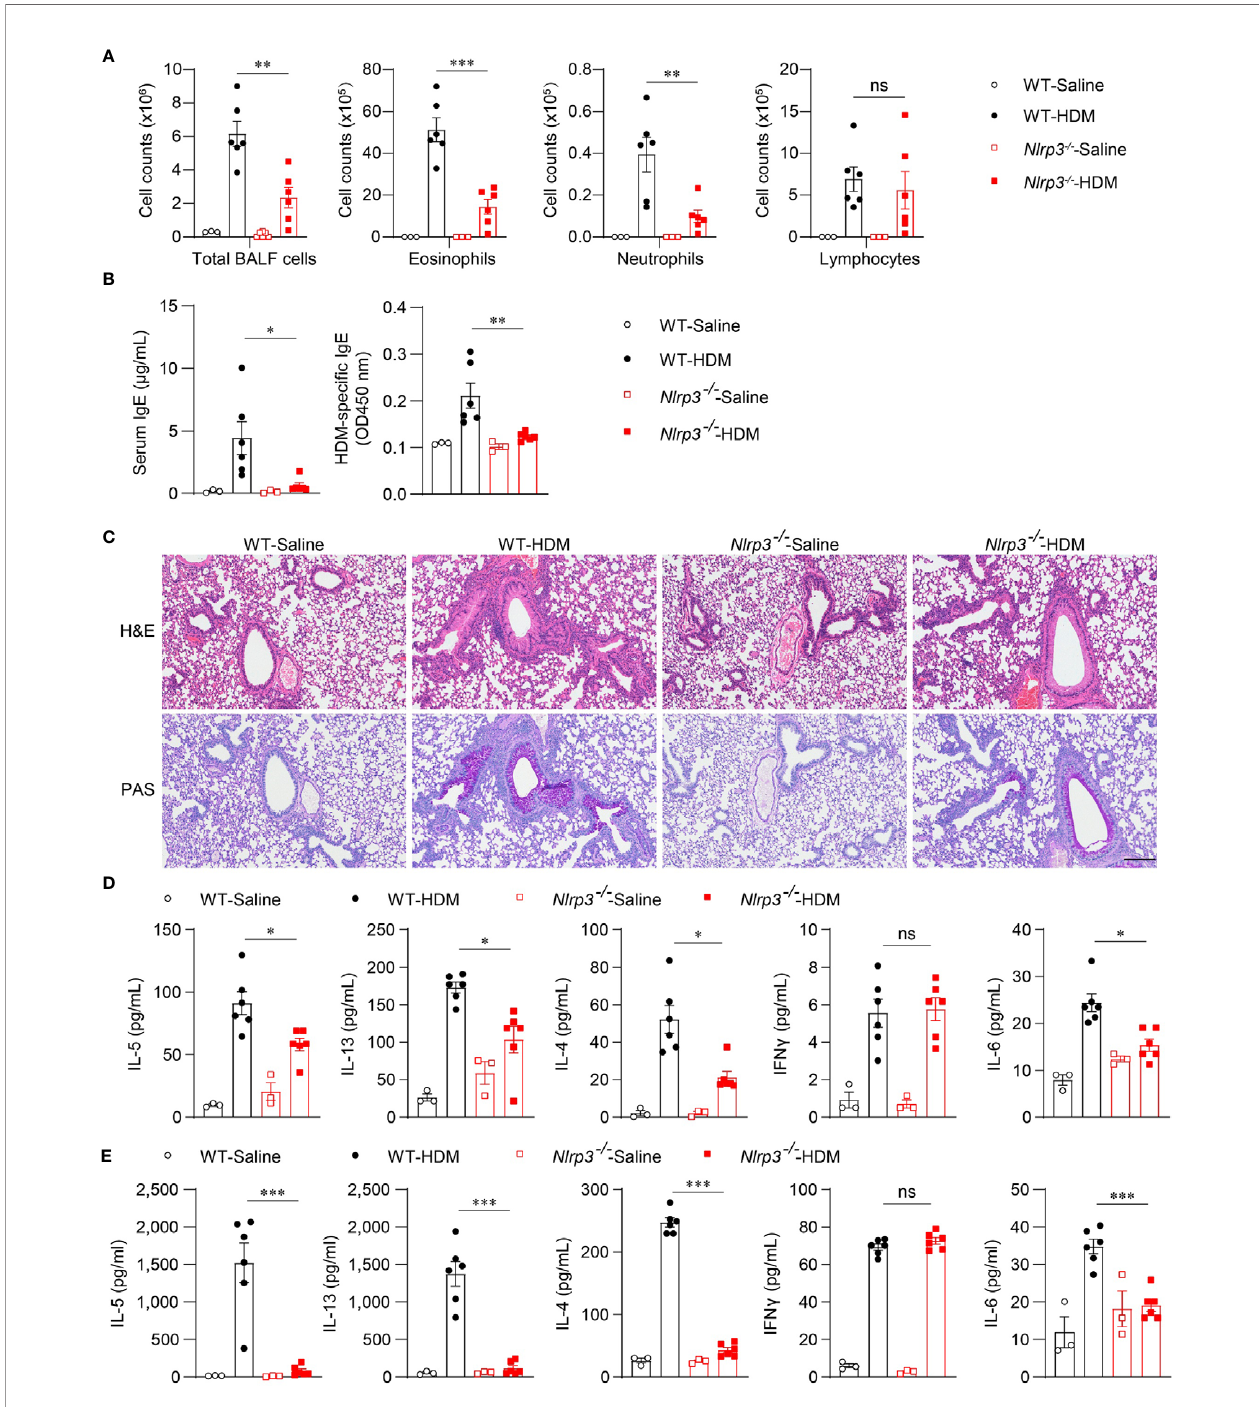
FIGURE 3 | NLRP3 de fi ciency attenuates airway in fl ammation HDM-induced asthma. (A – E) WT and Nlrp3 -/- mice were sensitized and challenged with 10 m g HDM i.n. on day 0 and days 7-11. The mice in control group were sensitized and challenged by inhaling saline. On day 14, all mice were euthanized for analysis. (A) counts of total BALF cells, eosinophils, neutrophils and lymphocytes. (B) ELISA analysis of IgE and HDM-speci fi c IgE in serum. (C) Histological analysis of lung sections stained with H&E and PAS (Scale bar = 200 m m); n = 3 biologically independent experiments. ELISA analysis of IL-4, IL-5, IL-13, IL-6 and IFN g in BALF (D) and supernatants of MLN cells obtained from control or challenged mice after or without restimulation with HDM (E) . n = 3-6 biologically independent mice (A, B, D, E) . Statistical signi fi cances were analyzed by unpaired Student ’ s t -test: * P < 0.05, ** P < 0.01, *** P < 0.001, ns (not signi fi